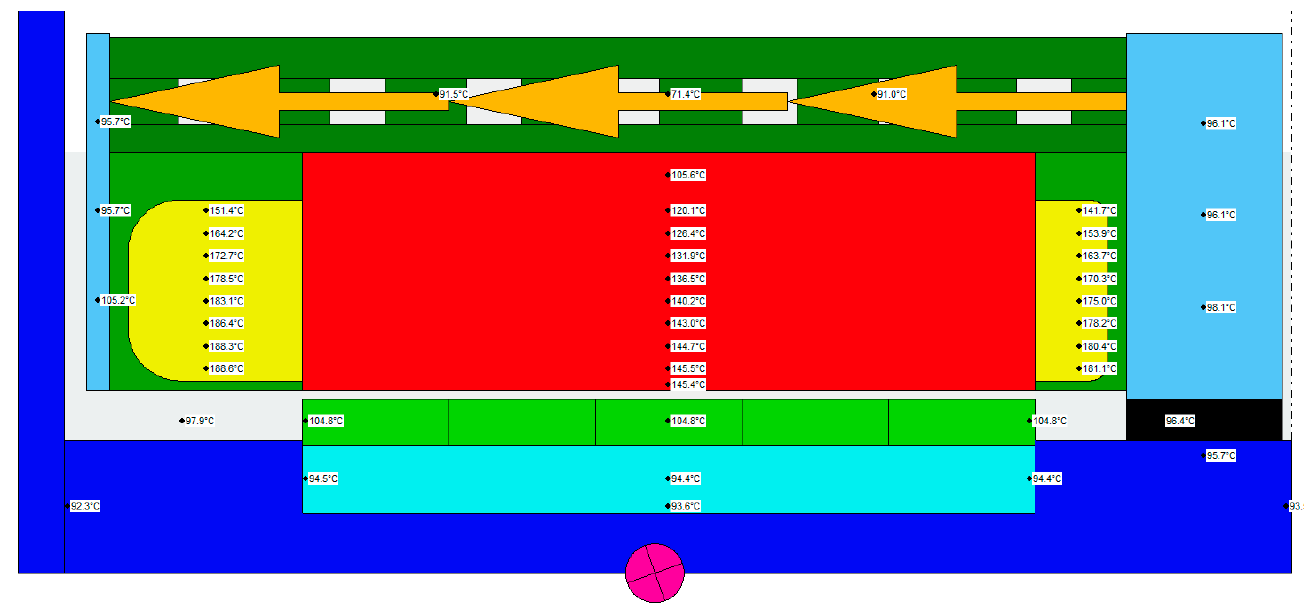
Figure 8. Calculation results of the motor temperature distribution for the operating point T m = 902 Nm and n = 400 rpm .